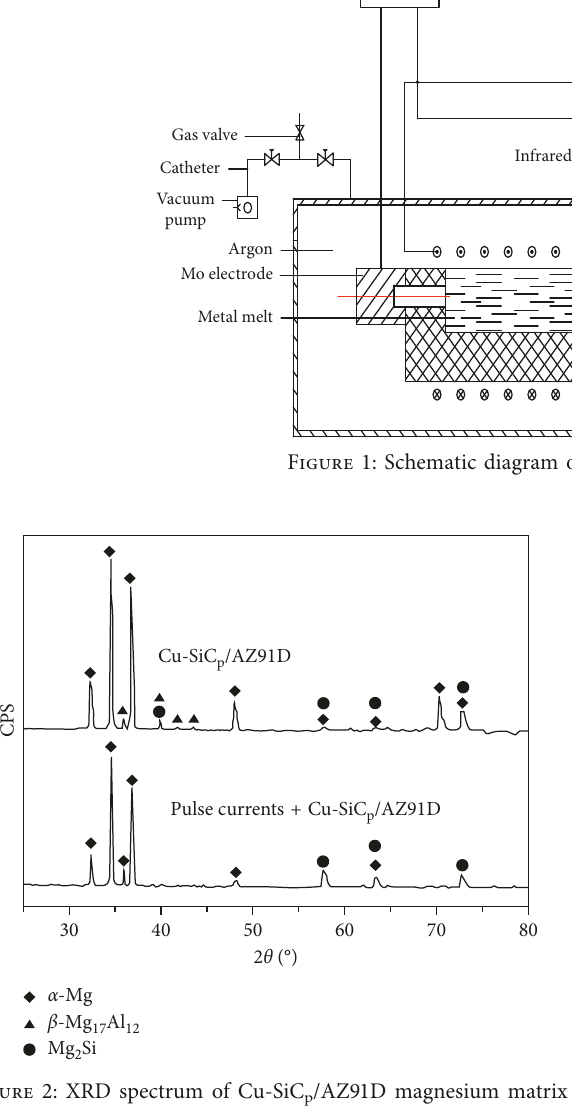
p /AZ91D magnesium matrix com-